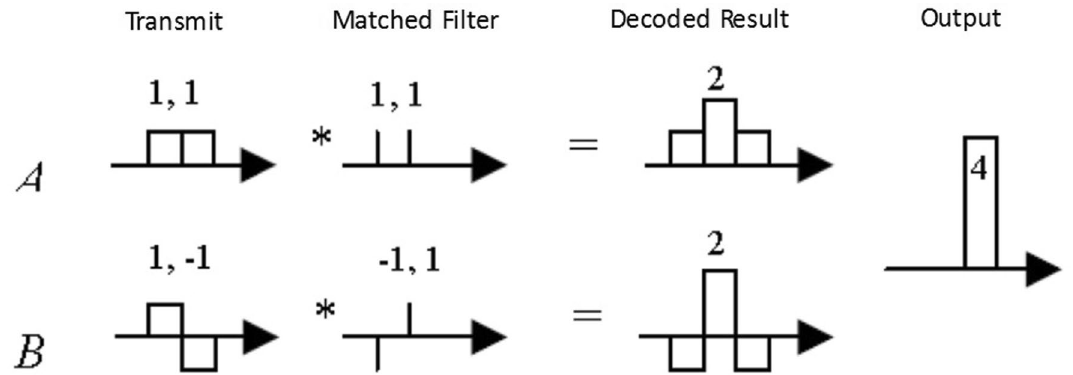
Figure 8. Pulse compression of the Golay